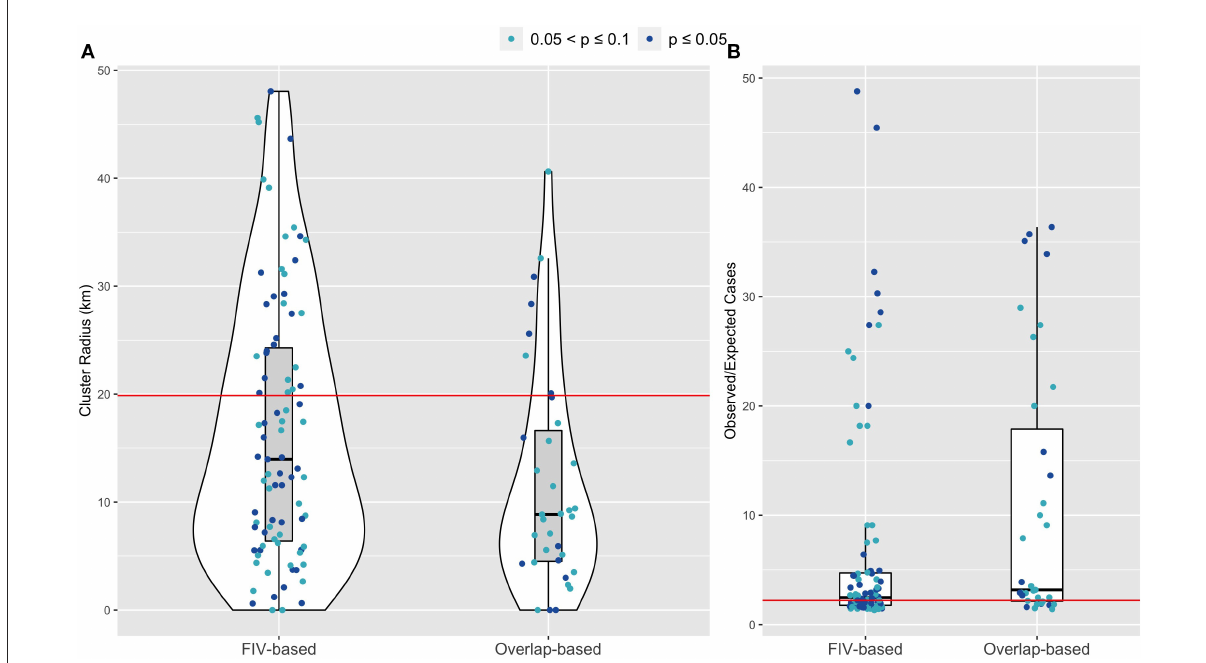
FIGURE4 SaTScan cluster analysis for feasible FIV-based and overlap-based network simulations show stronger agreement for the FIV-based model, compared to the overlap-based model, between empirical observations (red horizontal lines) and model predictions for (A) FeLV cluster size and (B) Observed/Expected FeLV cases associated with the top detected cluster. The overlap-based model, with locations assigned based on matching FIV-based simulations, served as a “negative control” for comparison to the FIV-based model’s spatial predictions. Shown are feasible simulation results in which at least one cluster was detected with p -values ≤ 0.1; further, if SaTScan identified more than one cluster, only the results from the most well supported (i.e., top cluster) are